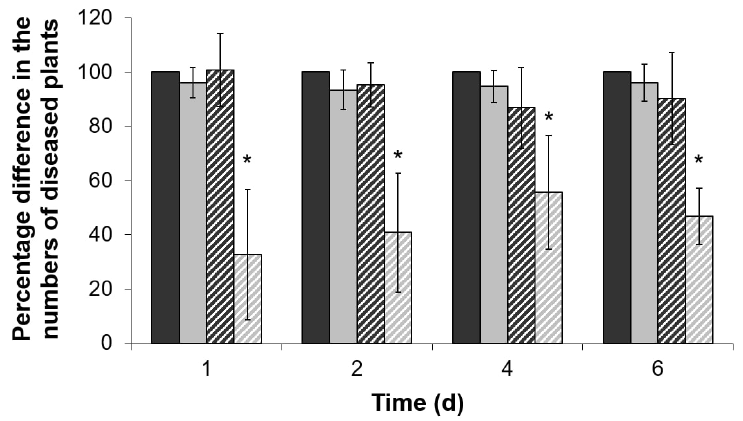
Figure 4. The disease incidents caused by the wild type Pectobacterium atrosepticum SCRI1043 (dark gray) or its ∆ entA mutant (light grey) on mock-treated (solid columns) or 0.2 mM salicylic acid-treated (hashed columns) tobacco plants. The number of the diseased plants in mock-treated group infected by the wild type was equated to 100% in each time point. The presented values are means ± SD of four independent experiments performed at 15–25 biological replicates each. Asterisks (*) show the significance of difference (Mann–Whitney two-sided test, p < 0.05).